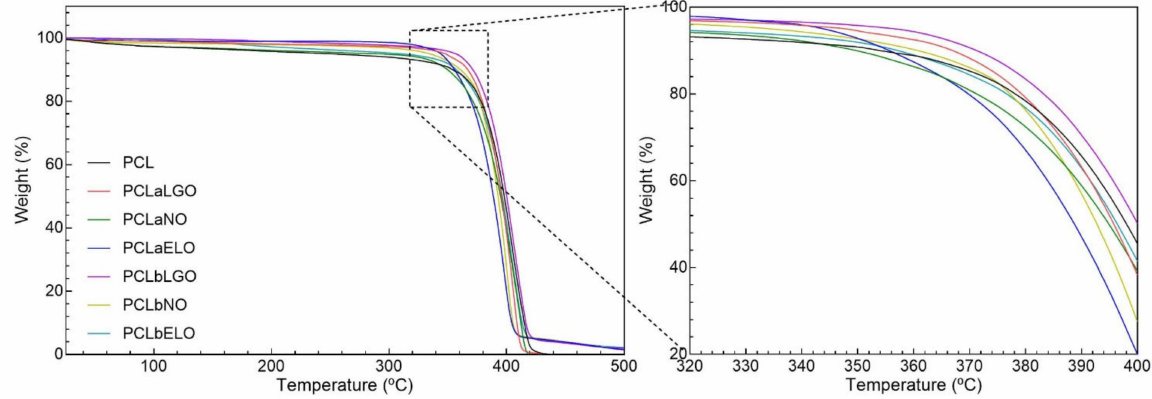
Figure 4. TGA spectra of the PCL-based mats obtained from 25 to 500 ◦ C under nitrogen atmosphere, flow rate of 200 mL/min and temperature rise of 10 ◦